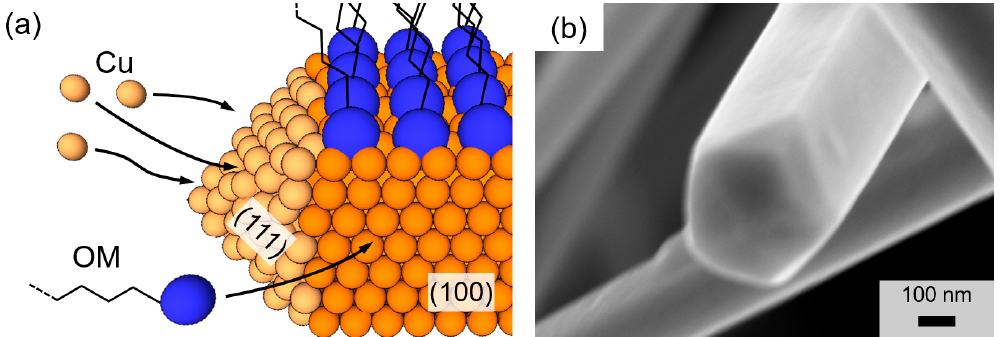
Figure 1. ( a ) Schematic for the growth of a single copper nanowire (CuNW) along the (111)-plane. The blue and orange spheres indicate oleylamine (OM) head groups and copper atoms, respectively. ( b ) High-resolution field-emission scanning electron microscope (FESEM)-image for a single copper nanowire with the characteristic pentagonal shaped cross-section.